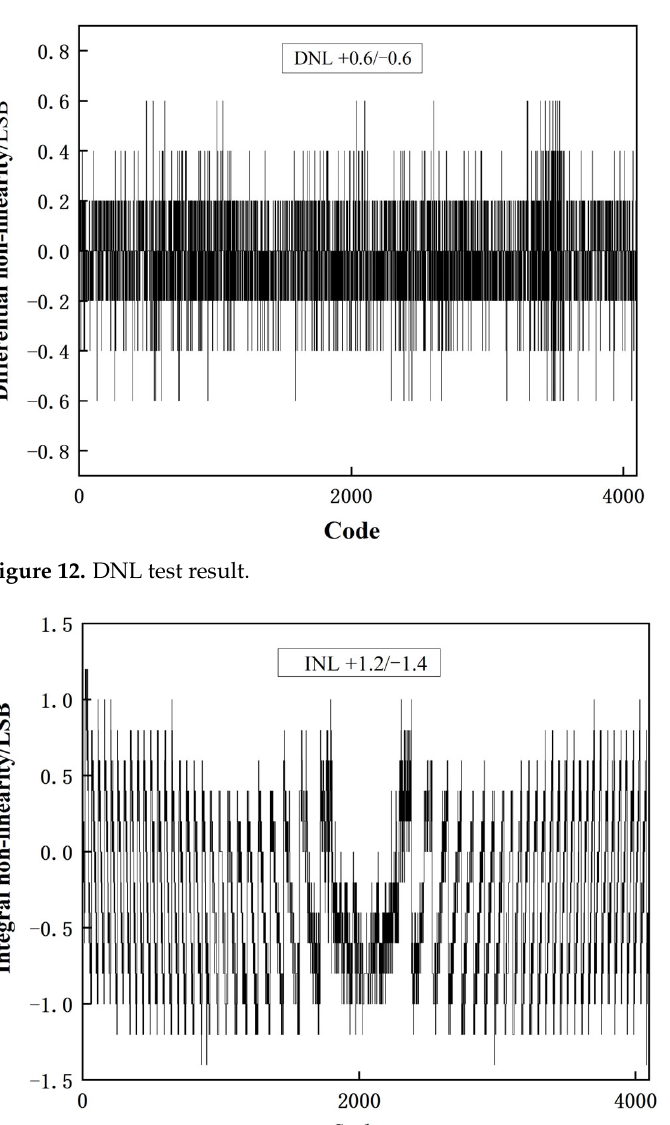
Figure 11. ADC overall layout.